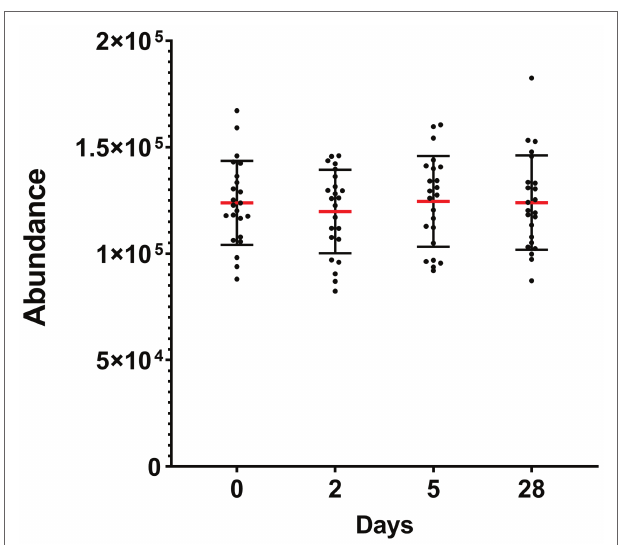
FIGURE 3 | Total abundance of the oral bacterial communities in saliva from commercial saturation divers ( n = 23) before, during, and after 28 days of heliox saturation, displayed as the number of reads for all detected OTU after 16S sequencing. For each time-point, means (red line) and individual values are shown. Error bars are ±1 SD. Day 0, before saturation; days 2 and 5, during the bottom phase; day 28, after